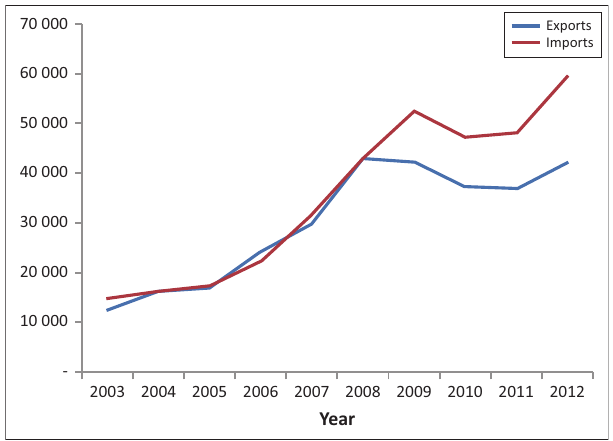
FIGURE 1: Namibian imports and exports,